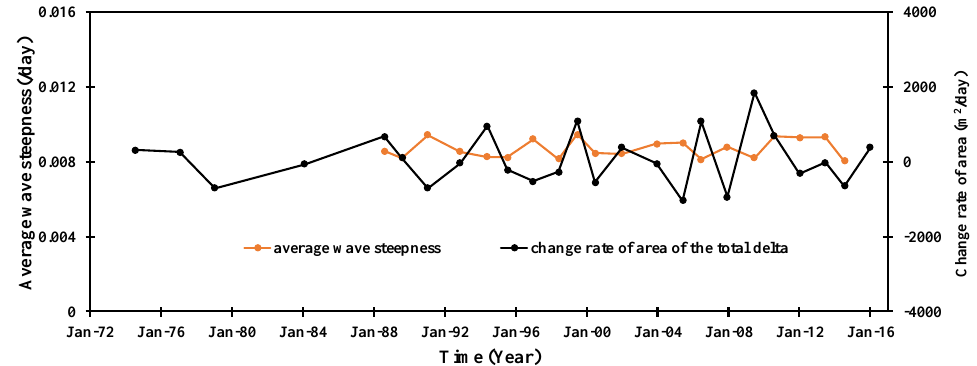
Figure 15. Relation between the change rates of the area of the delta (total, northern, and southern) and average wave steepness.